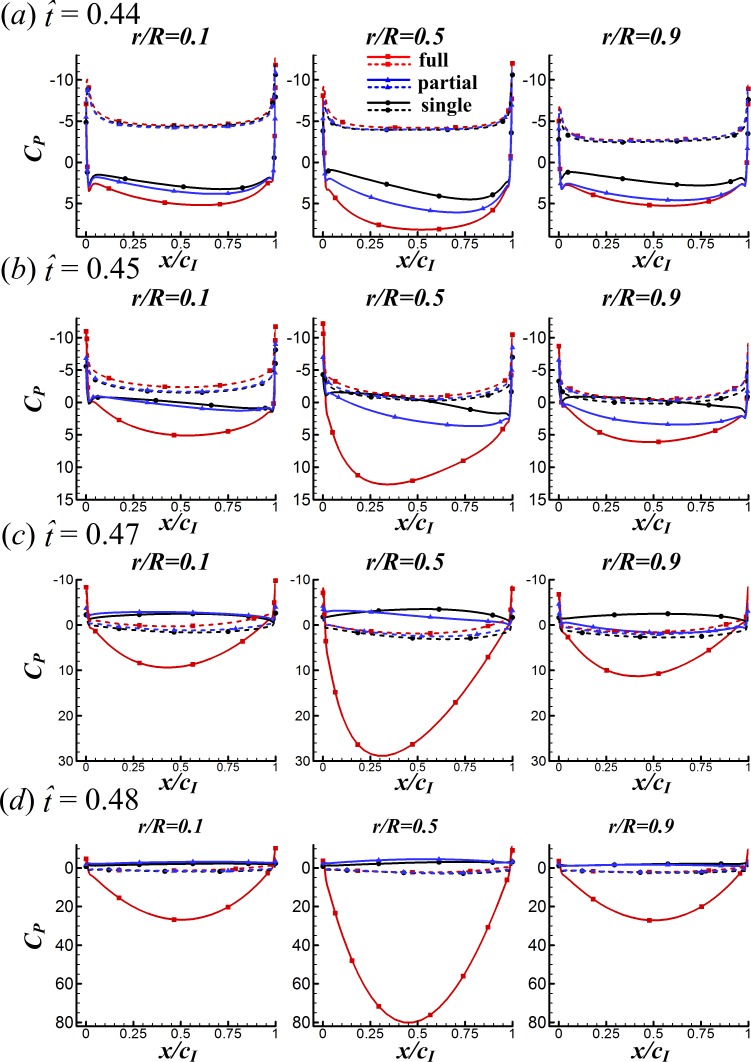
Surface pressure distributions of the three cases at various spanwise positions for \documentclass[12pt]{minimal}
\usepackage{amsmath}
\usepackage{wasysym}
\usepackage{amsfonts}
\usepackage{amssymb}
\usepackage{amsbsy}
\usepackage{upgreek}
\usepackage{mathrsfs}
\setlength{\oddsidemargin}{-69pt}
\begin{document}
}{}$\hat {t}=0.44$\end{document}t ˆ=0.44, 0.45, 0.47 and 0.48 in the clap phase (solid and broken lines indicate the pressure distribution on the lower surface and the upper surface, respectively).